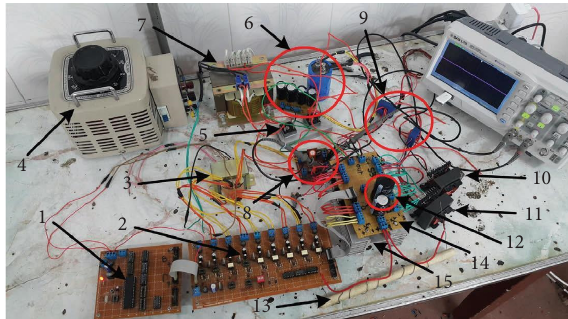
Figure 29: Experimental prototype.